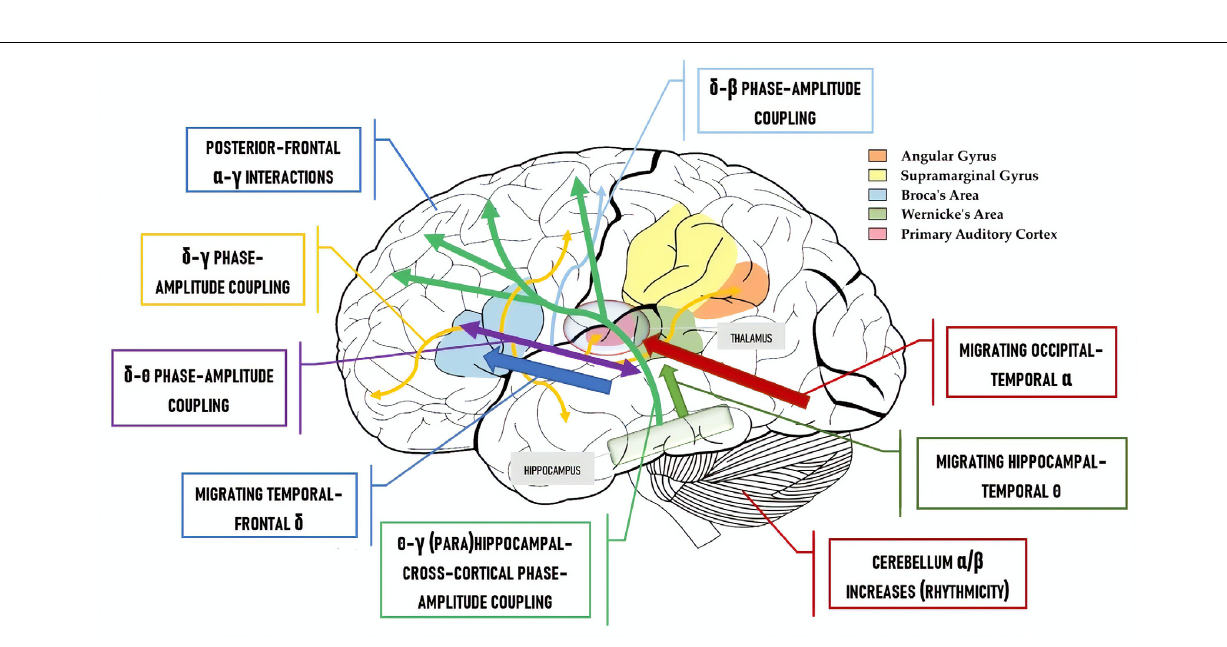
arrow and purple box). Traveling δ waves are assumed to